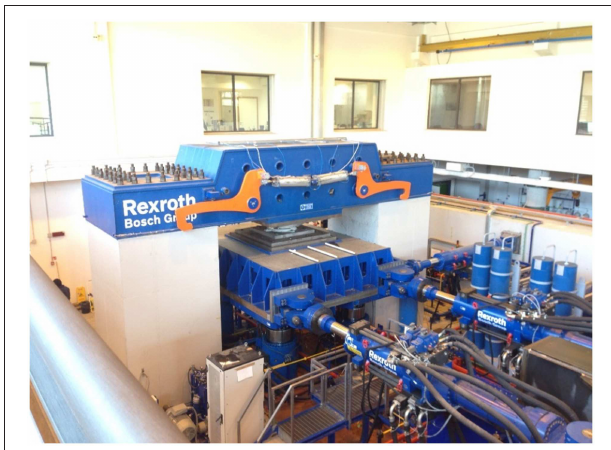
FIGURE 3 | Photograph of the laboratory CERISI, University of Messina, Italy.